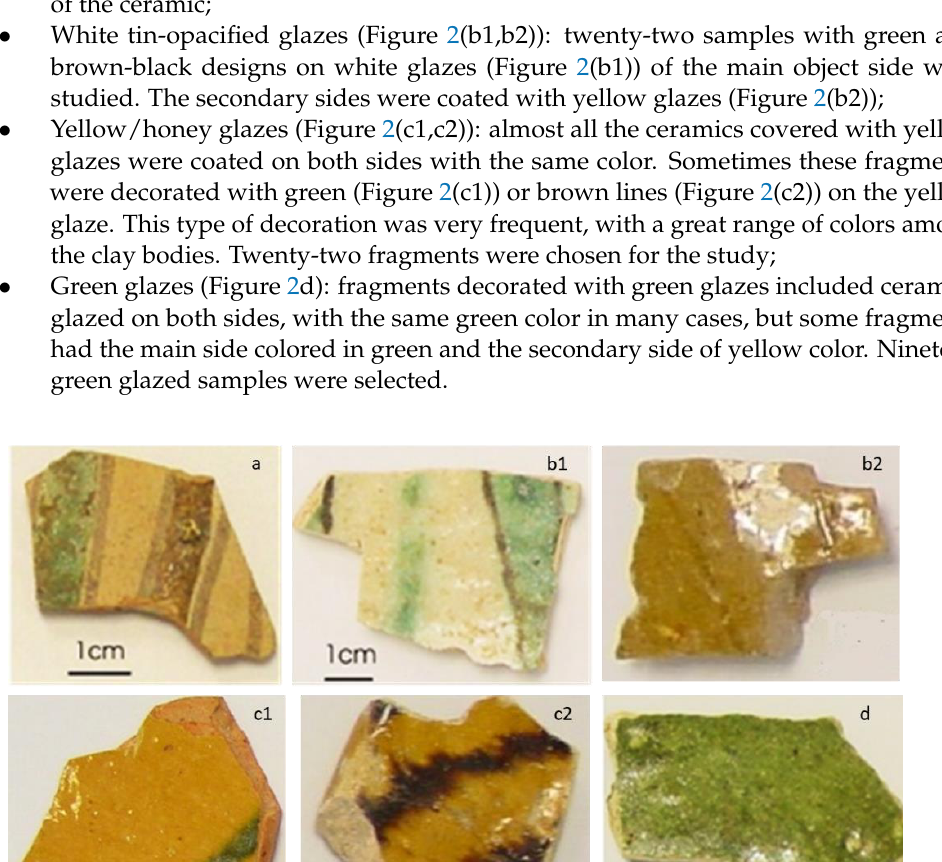
Spectrometer (ICP-OES) (Thermo, Bremen, Germany). Powdered samples were